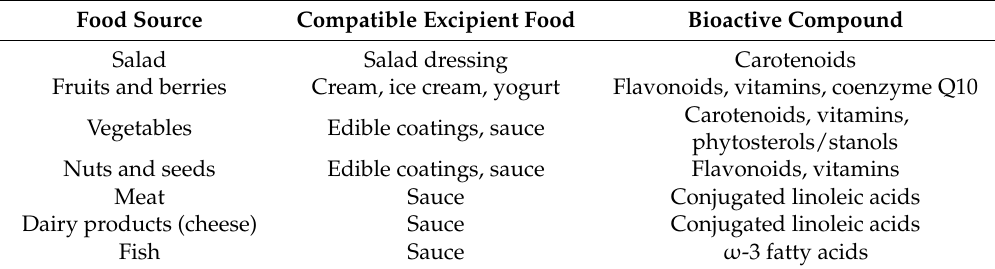
Table 1. Examples of potential excipient foods to be co-ingested with natural food products to enhance the oral bioavailability of bioactive compounds.